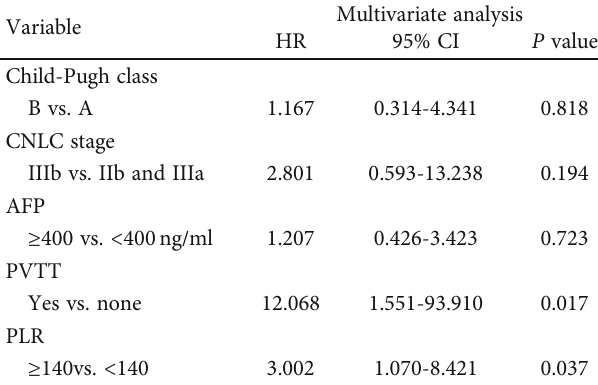
Table 7: Multivariate Cox proportional hazards regression models for overall survival.